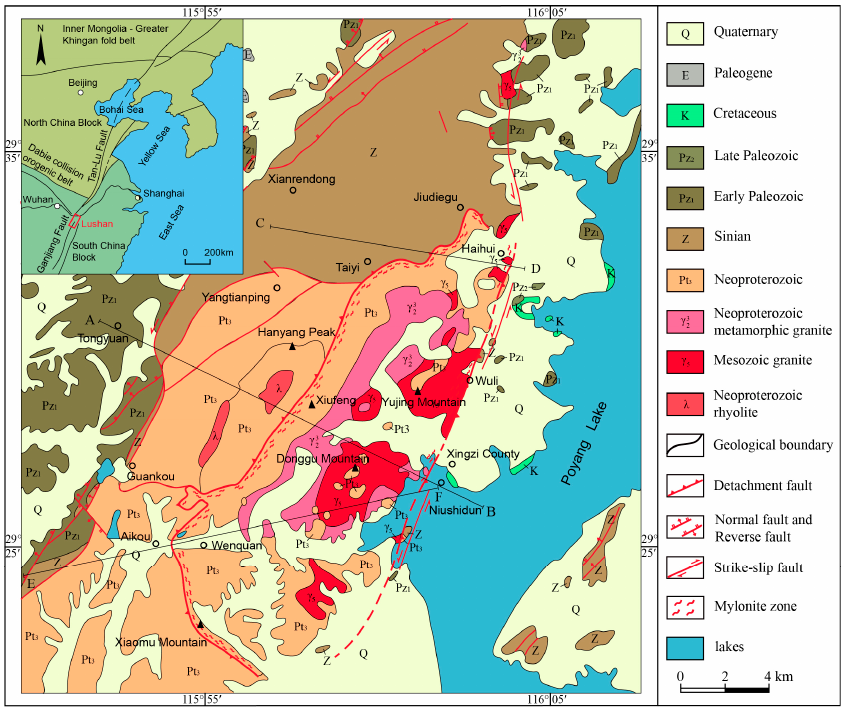
Figure 1. Geological map of the Lushan area (modified from 916 geological party of JiangXi bureau of geology and exploration, 2003).